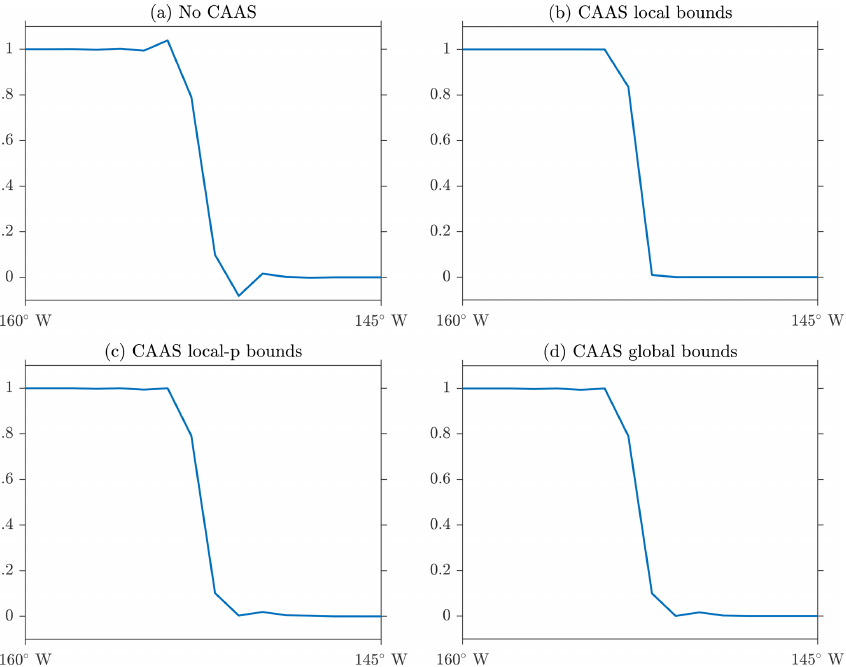
Figure 6. One-dimensional cross sections for remapping of a discontinuous field at the Equator. Panel (a) shows the results without CAAS, (b) shows the results using CAAS with local bounds preservation, (c) shows the results using CAAS with local- p bounds preservation, and (d) shows the results using CAAS with global bounds preservation.